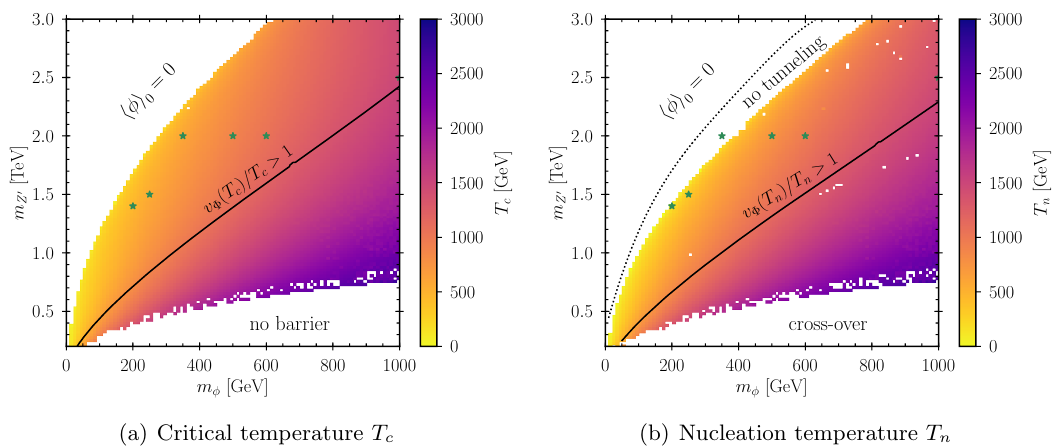
Figure 16 . Parameter points with two phases separated by a potential barrier at a critical tem- perature T c (left), and points that give rise to a cosmological (cid:12)rst-order phase transition with a nucleation temperature T n (right). The colored regions above the solid, black line feature strong transitions with v (cid:8) ( T ) =T > 1 at T c or T n , respectively. The dotted line in the right plot denotes the border at which (cid:30) = 0 becomes a global minimum. The values of T c and T n for the benchmark points marked by a star can be found in appendix